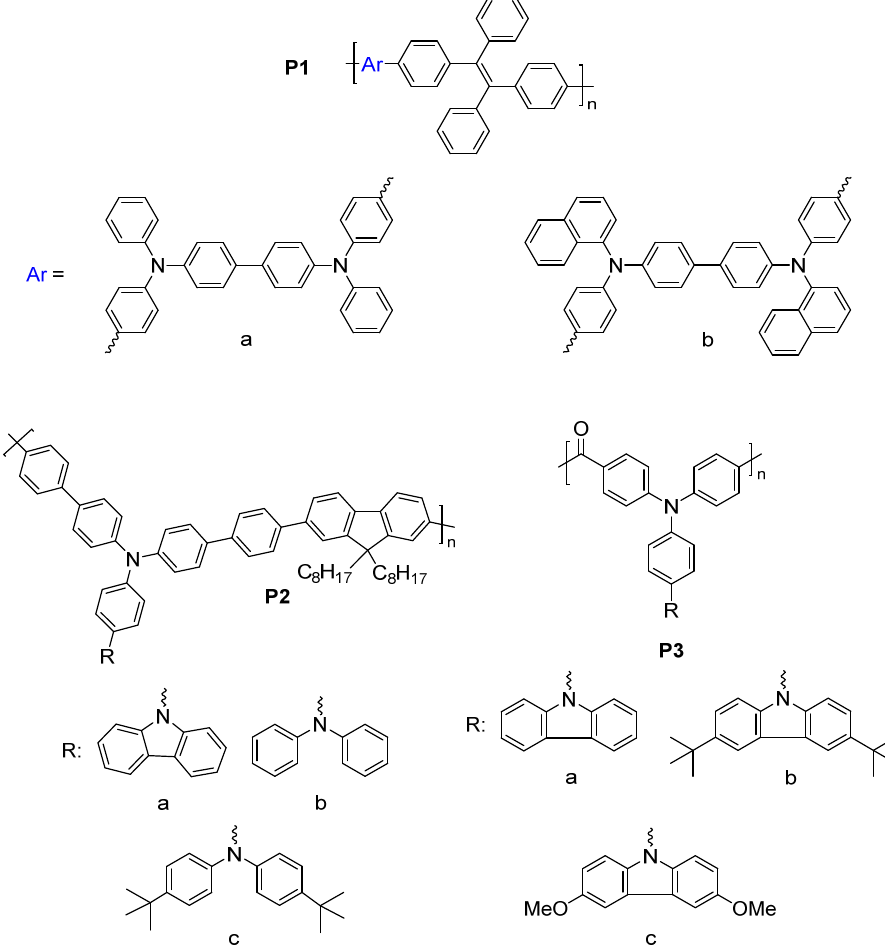
Figure 11. Representative structures of TPA ‐ containing polymers used as electrofluorochromic materials [135–137].